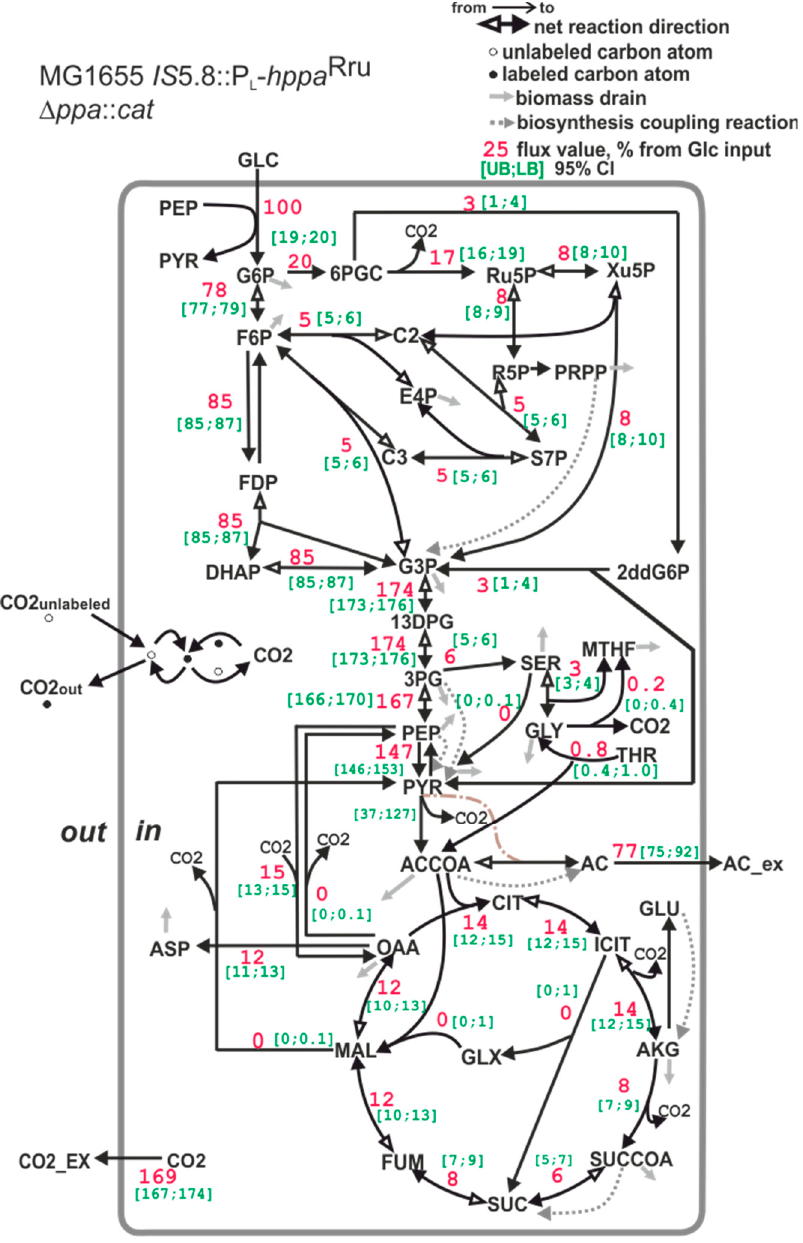
Figure 8. The carbon flux distribution in the E . coli MG1655 IS 5.8::P L - hppa Rru ∆ ppa:: Cm R strain. For details, see the caption of Figure